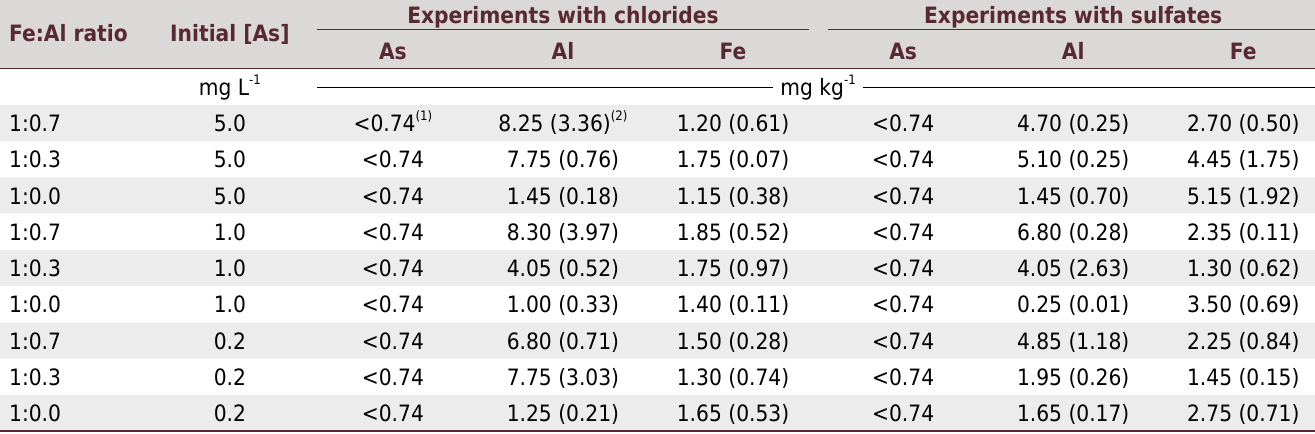
The number after the symbol < means the detection limit of the analytical method. (2) Numbers between brackets are the two-sigma standard deviation of